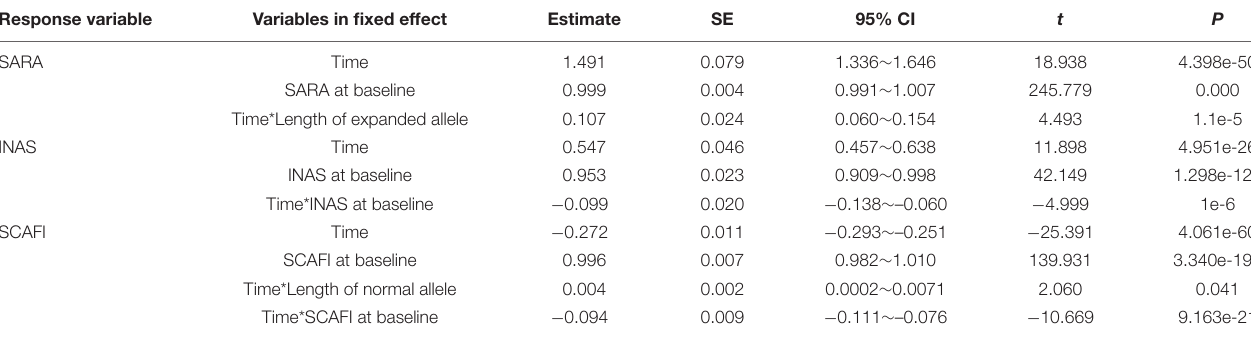
TABLE 2 | Linear mixed-effect modeling for multivariable affecting SARA, INAS, and SCAFI progression. Response